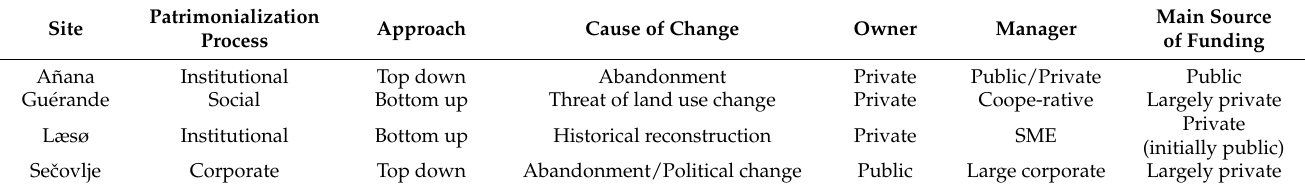
Table 2. Main features of the four study sites. Own